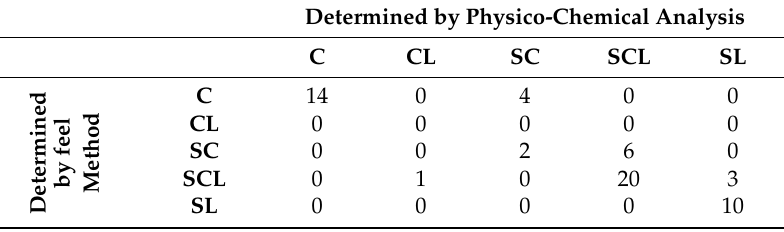
Table 3. Confusion matrix obtained from 60 soil textural classes determined from both physico-chemical analysis and the feel method over soil samples collected on 17 soil profiles on the Berambadi